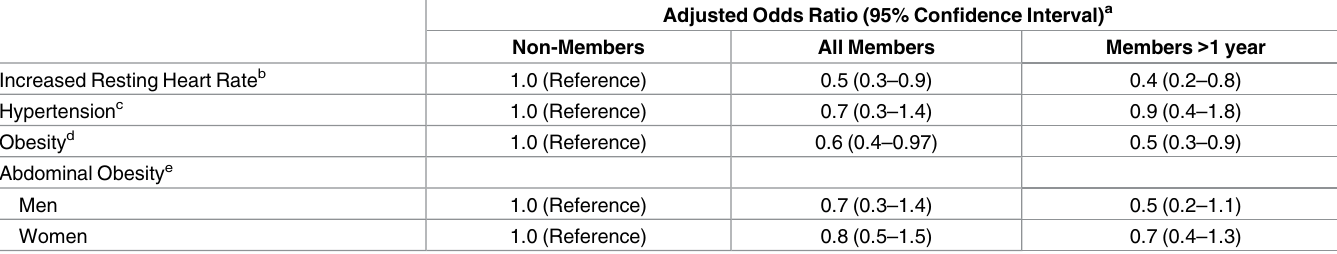
Table 4. Odds ratios of cardiovascular health outcomes by health club membership status in all members and memberswith over 1 year of